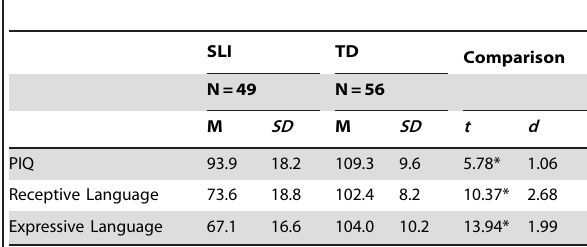
Table 1. Descriptive statistics for young people with SLI and TD peers at around 17 years of